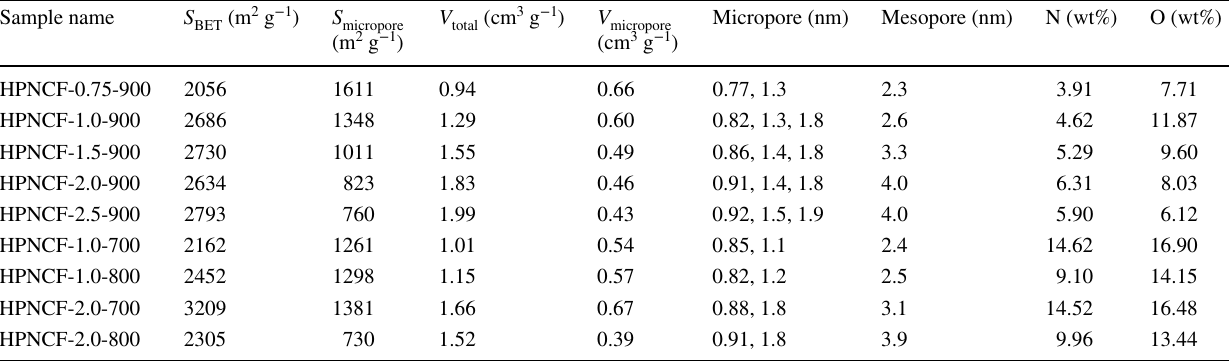
Table 1 Summary of the textural properties and the N and O contents of the HPNCFs obtained at various PBC/His molar ratios and tempera-